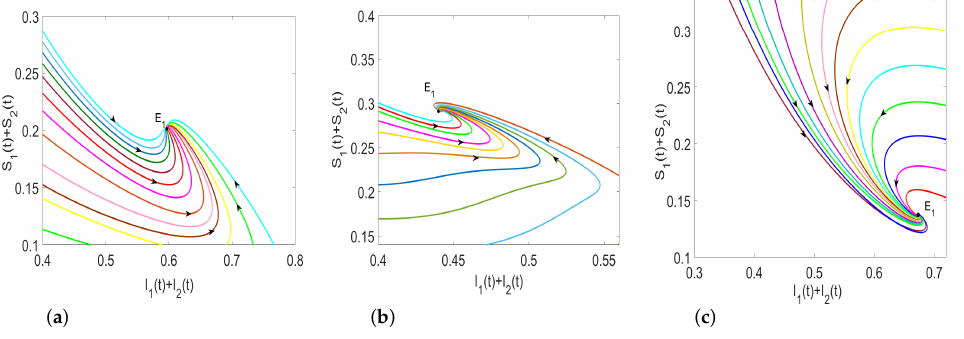
Figure 10. The phase diagram of S 1 ( t ) + S 2 ( t ) and I 1 ( t ) + I 2 ( t ) . ( a ) (cid:60) 01 = 2.14 > 1 and (cid:60) 02 = 0.97 < 1. ( b ) (cid:60) 01 = 2.14 > 1 and (cid:60) 02 = 1.9 > 1. ( c ) (cid:60) 01 = 1.48 > 1 and (cid:60) 02 =